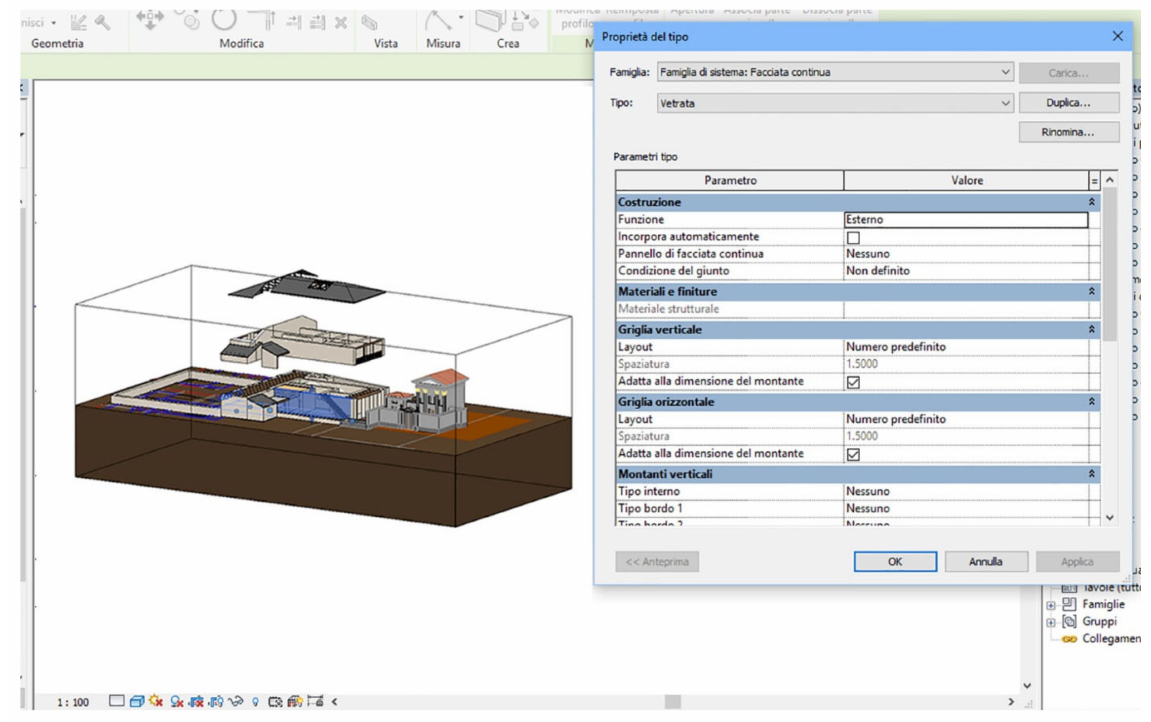
Figure 6. References in Revit software of the information on and characteristics of the